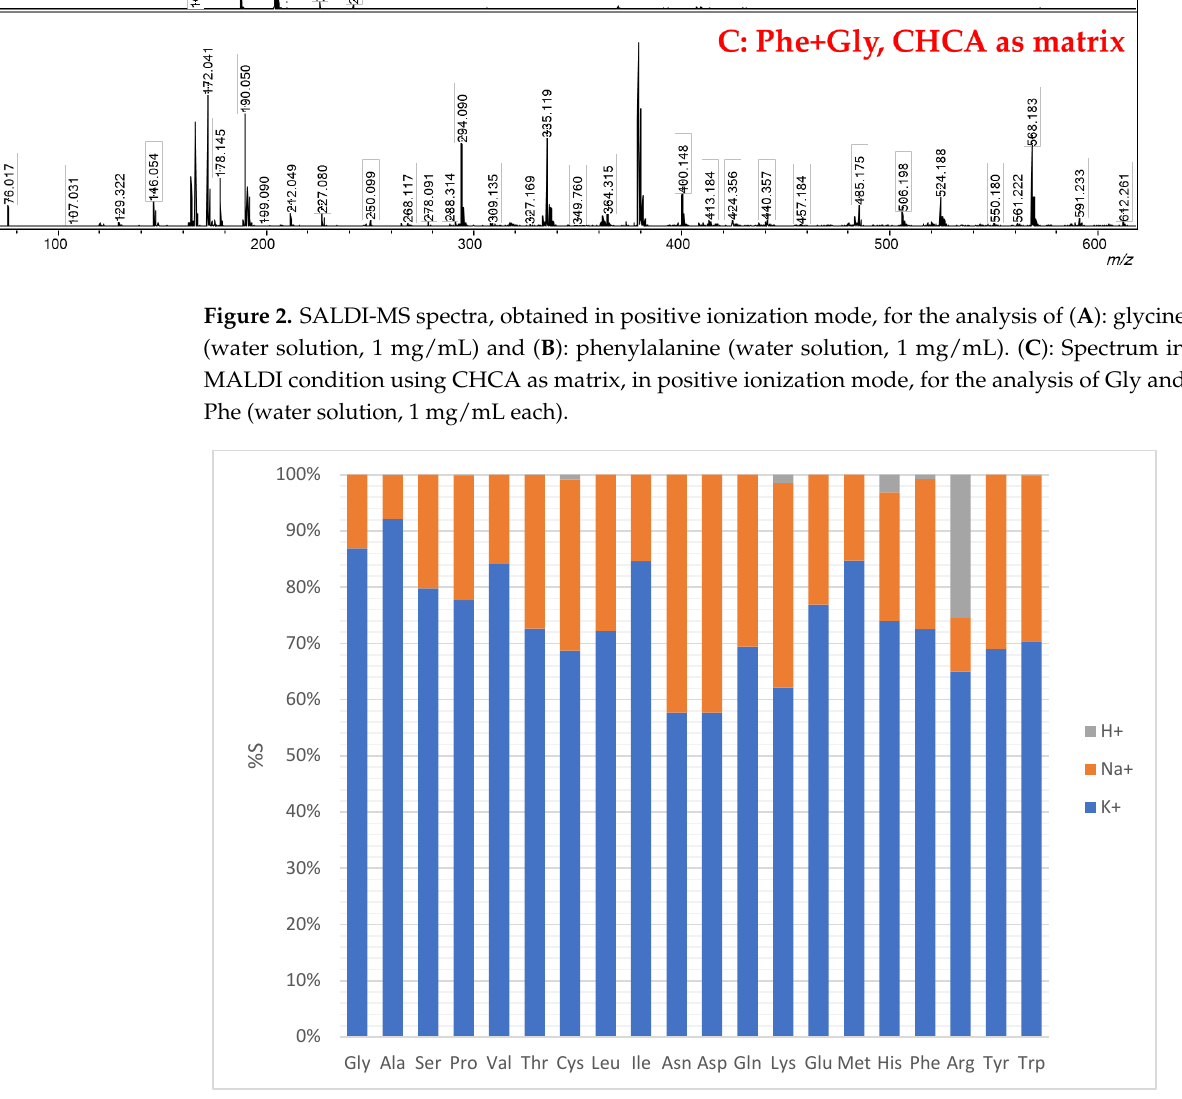
Figure 3. Percentage (%S) of potassium (blue), sodium (orange) and protonated (gray) adducts with respect to the sum of the three signals formed for each of the considered amino acids in SALDI condition, positive ion